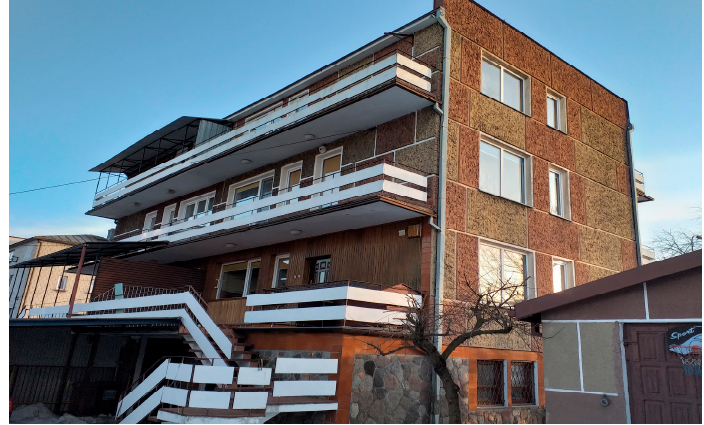
Figure 1. Concentration of carbon dioxide in a bedroom (photograph by Wojciech Fiedoruk).